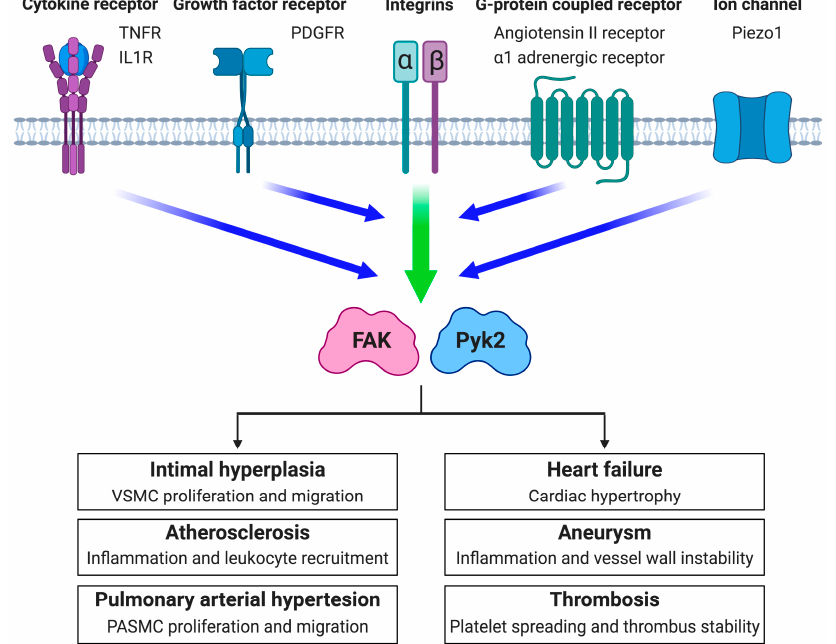
autophosphorylation site. Y402: Pyk2 autophosphorylation site. a.a.: Amino acids. N: N-terminal. C: C-terminal.